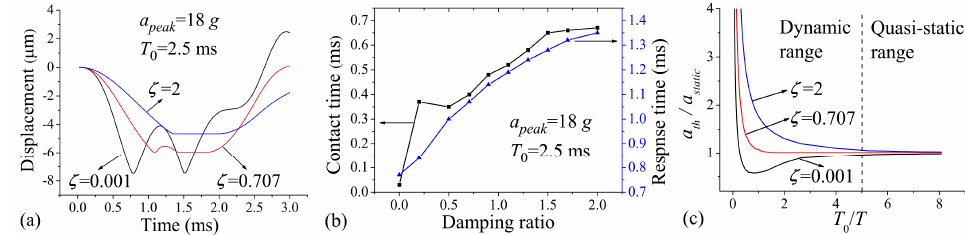
Figure 3. ( a ) Displacement vs. time when a peak = 18 g , T 0 = 2.5 ms, and ζ = 0.001, 0.7, and 2, respectively; ( b ) Contact time vs. damping ratio and response time vs. damping ratio when a peak = 18 g and T 0 = 2.5 ms; ( c ) a th / a static vs. T 0 / T when ζ = 0.001, 0.7, and 2,